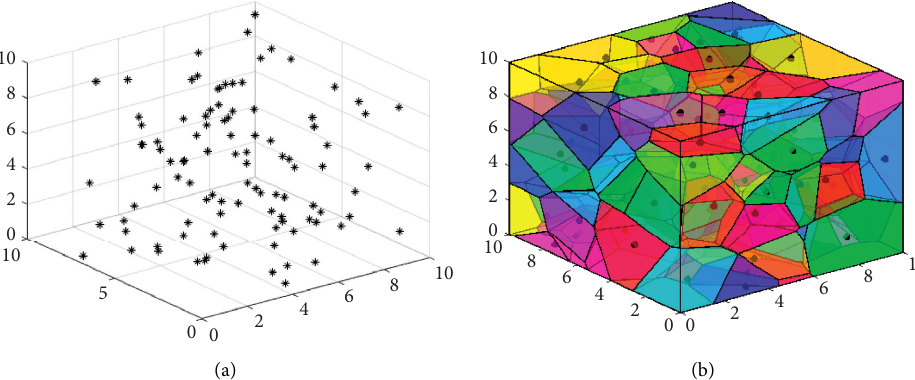
Figure 3: Voronoi diagram generated by N discrete points. (a) Generation of discrete points. (b) Division of volume.